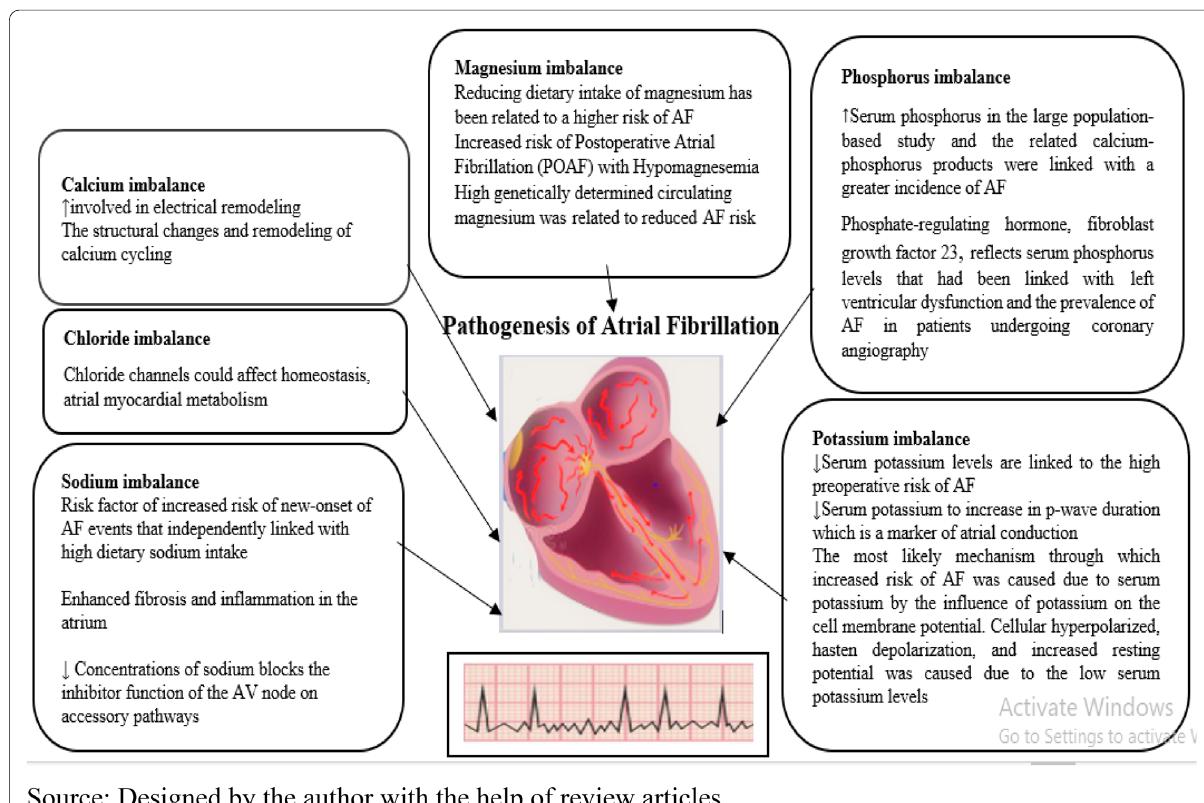
Fig. 2 Role of major electrolytes imbalance lead pathogenesis of AF Source: Designed by the author with the help of review